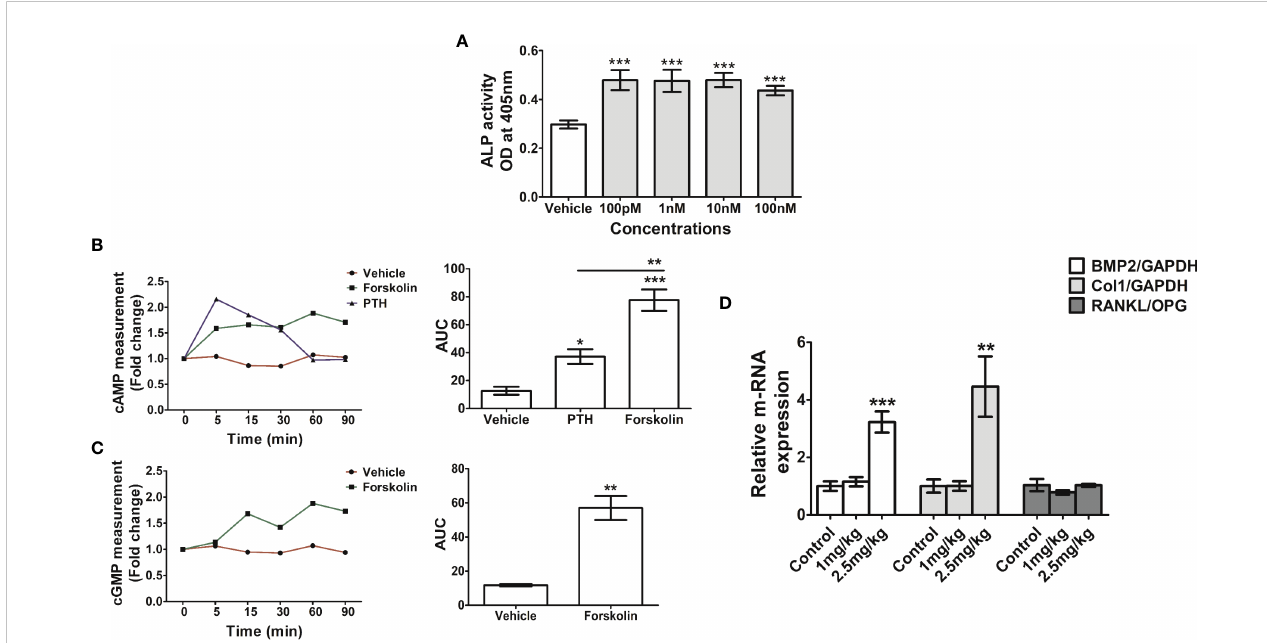
FIGURE 5 Forskolin has osteogenic effect in vitro and in vivo . (A) RCO were treated with forskolin at the indicated concentrations and differentiation was assessed by ALP assay. (B) RCO were treated with forskolin (10nM) for the indicated time points and intracellular cAMP and (C) cGMP production were measured. (D) Rat pups (1-day old) were injected with forskolin at the indicated doses for 5 consecutive days and the relative expression of osteogenic genes in the calvarial tissue were measured. All values are expressed as mean ± SEM; *p <0.05, **p<0.01 and ***p<0.001 vs.